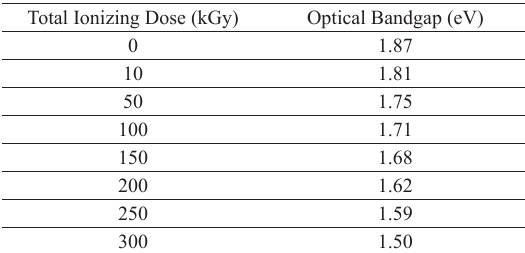
Table 2. Optical bandgap of TIPS Pentacene thin film. Total Ionizing Dose (kGy)